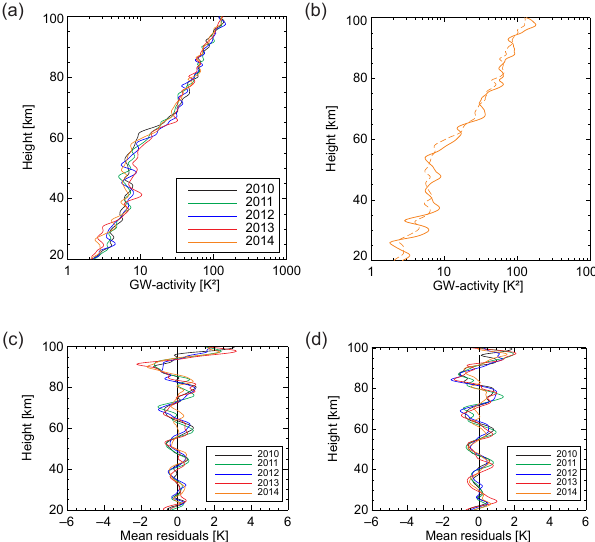
Figure 8. (a) As Fig. 1, for detrending the repeating cubic spline routine with equidistant sampling points as it is described in Sect. 2 is used. (b) Mean squared residuals for the repeating (dashed line) and the non-repeating (solid line) approach for the year 2014. (c) Mean (non-squared) residuals for the non-repeating approach for the years 2010 to 2014 and (d) mean (non-squared) residuals for the repeating